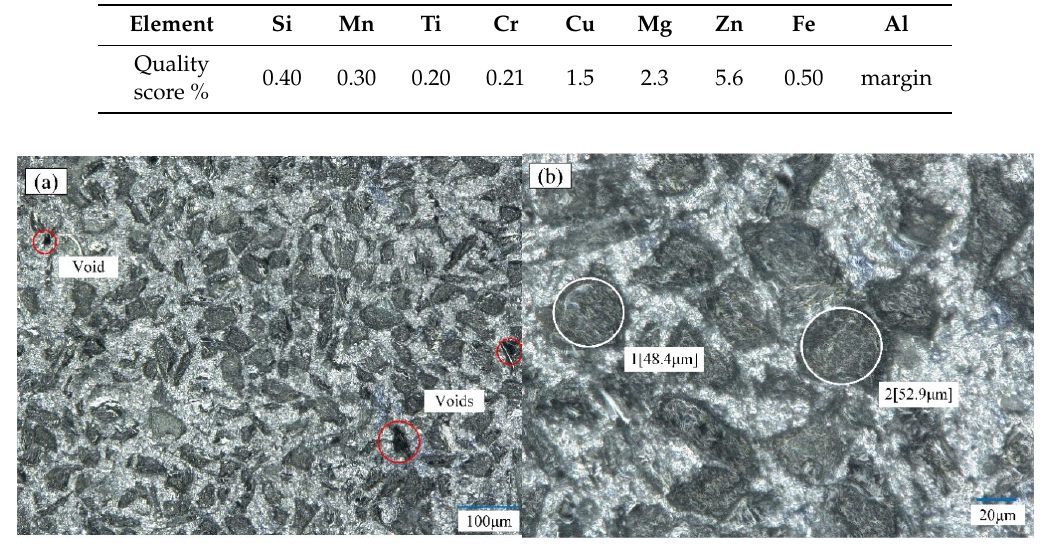
Figure 6. The observation of the surface morphology of the SiCp/Al composite ; ( a ) Scanning electron microscopy overall surface topography; ( b ) Sic particle size.